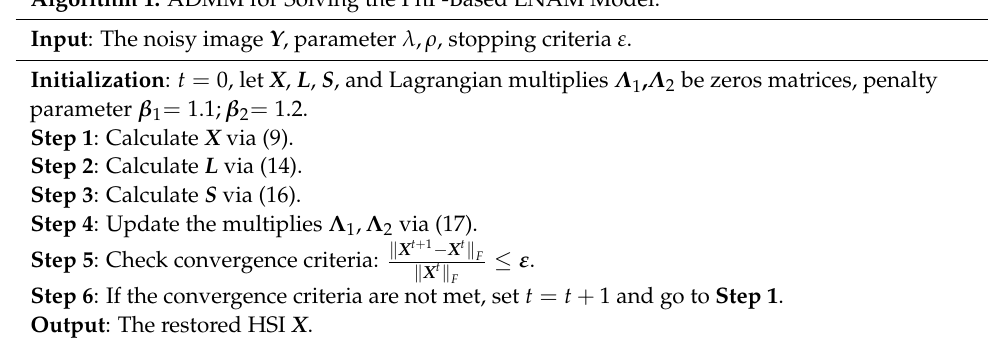
Algorithm 1. ADMM for Solving the PnP-Based LNAM